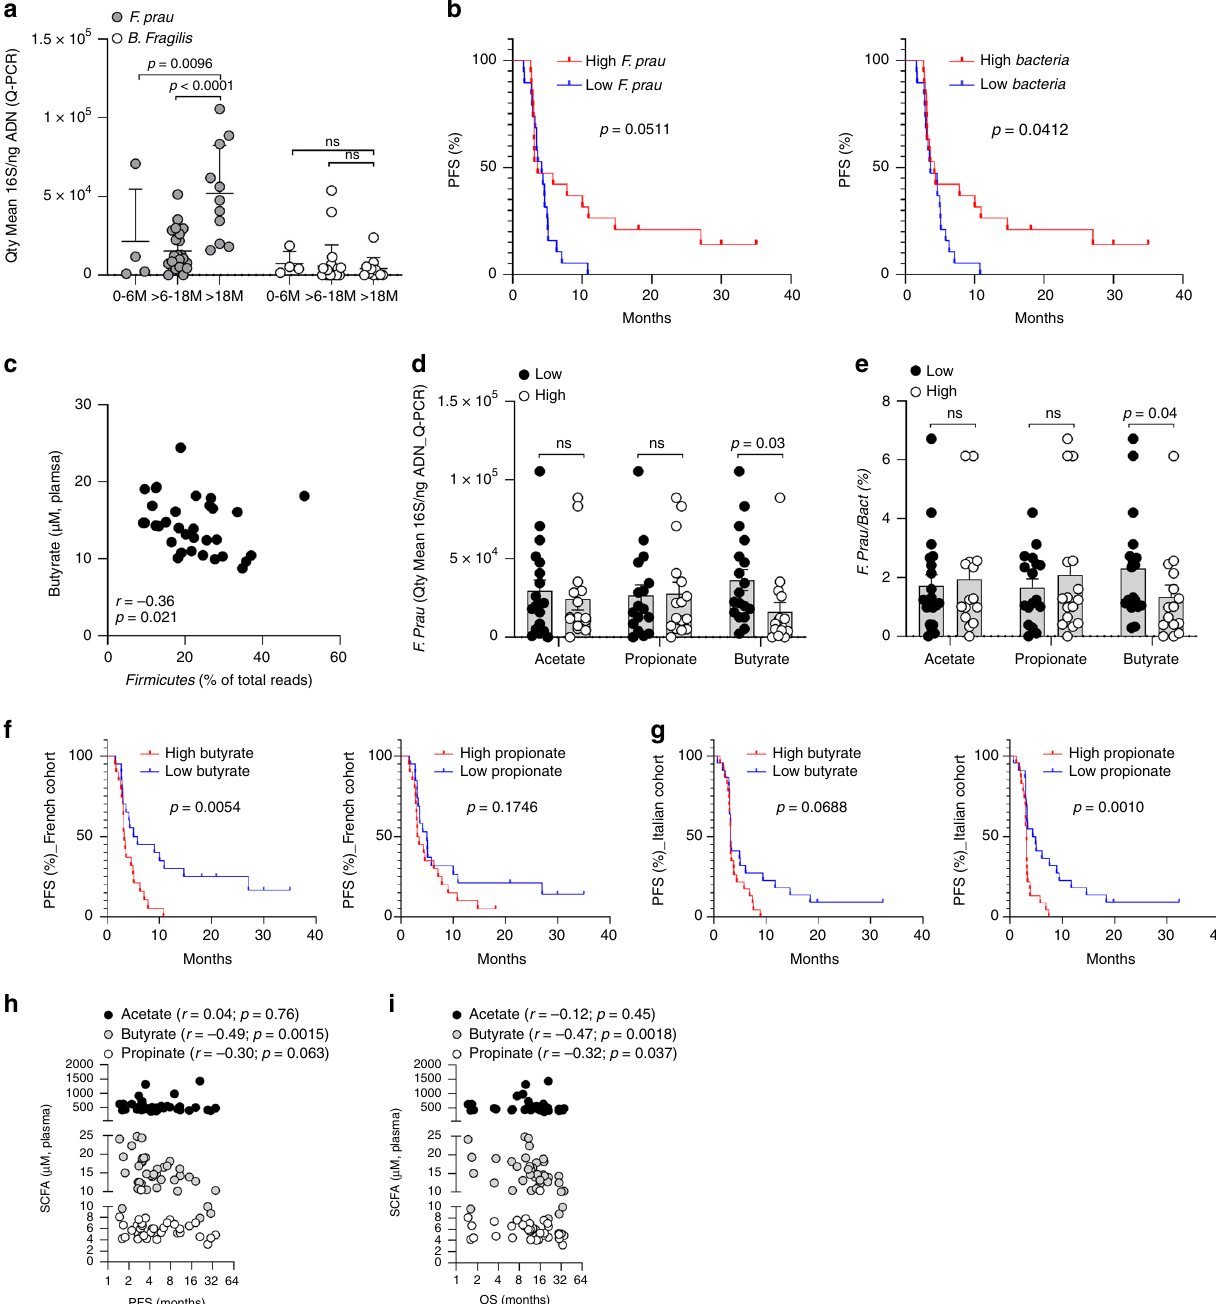
Fig. 2 Association between F. prausnitzii , systemic concentrations of SCFA and clinical outcomes. a Quantity Mean 16S/ng DNA of F. prausnitzii and B. fragilis at baseline (Q-PCR). Each patient ’ s microbiota is presented in the graph ( n = 38). 0 – 6 M: overall survival ranging from 0 to 6 months ( n = 4), >6 – 18 M: overall survival ranging from 6 to 18 months (n = 23), >18 M: overall survival >18 months ( n = 11). Two-Way ANOVA followed by Tukey ’ s tests for multiple comparisons was performed. p- values are indicated on each graph; ns, not signi fi cant. b Kaplan – Meier survival curves of PFS of patients classi fi ed into two groups according to median of F. prausnitzii /ng DNA (Low vs high F. prau ; left panel) and 16S BACTERIA/ ng DNA (low vs high Bacteria; right panel). Date were performed using Q-PCR analyses on feces at baseline ( n = 38), Log-rank (mantel-cox) test was used c Spearman correlation between the relative abundance of Firmicutes assessed by 16S DNA analysis (% of total reads NGS) and serum butyrate at baseline ( n = 33). d Q-PCR analyses on feces at baseline of F. prausnitzii ( 16S F.prau /ng DNA) according to the median concentrations of serum acetate, propionate and butyrate ( n = 33). e As in ( d ) but proportion ( n = 33). Each dot represents a mean quantity (assessed in duplicate for each sample) for one patient. Two-tailed Mann – Whitney tests were used ( d , e ). p- values are indicated on each graph; ns, not signi fi cant. Kaplan – Meier survival curves of PFS according to the median value of serum propionate (left panels) and butyrate (right panels) concentrations in French ( f , n = 40) and Italian ( g , n = 45) cohort, Log-rank (mantel-cox) test was used . h Pearson correlations between serum concentrations of acetate, butyrate and propionate and PFS ( n = 40) in French cohort; i As in ( h ) but for OS ( n = 40) in French cohort. Each dot represents one patient. p and r are indicated on each